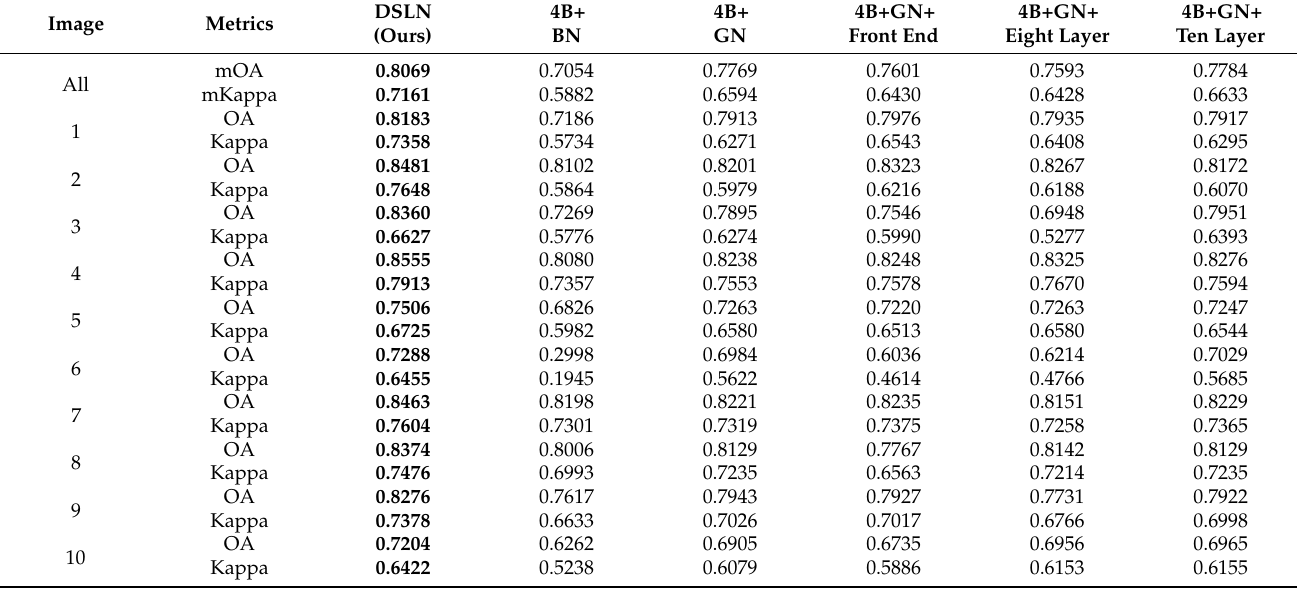
Table 5. Comparison of OA and Kappa with Different